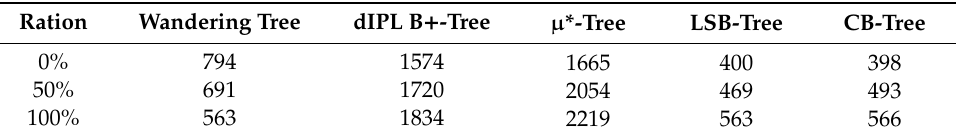
Table 6. The number of allocated pages on the flash